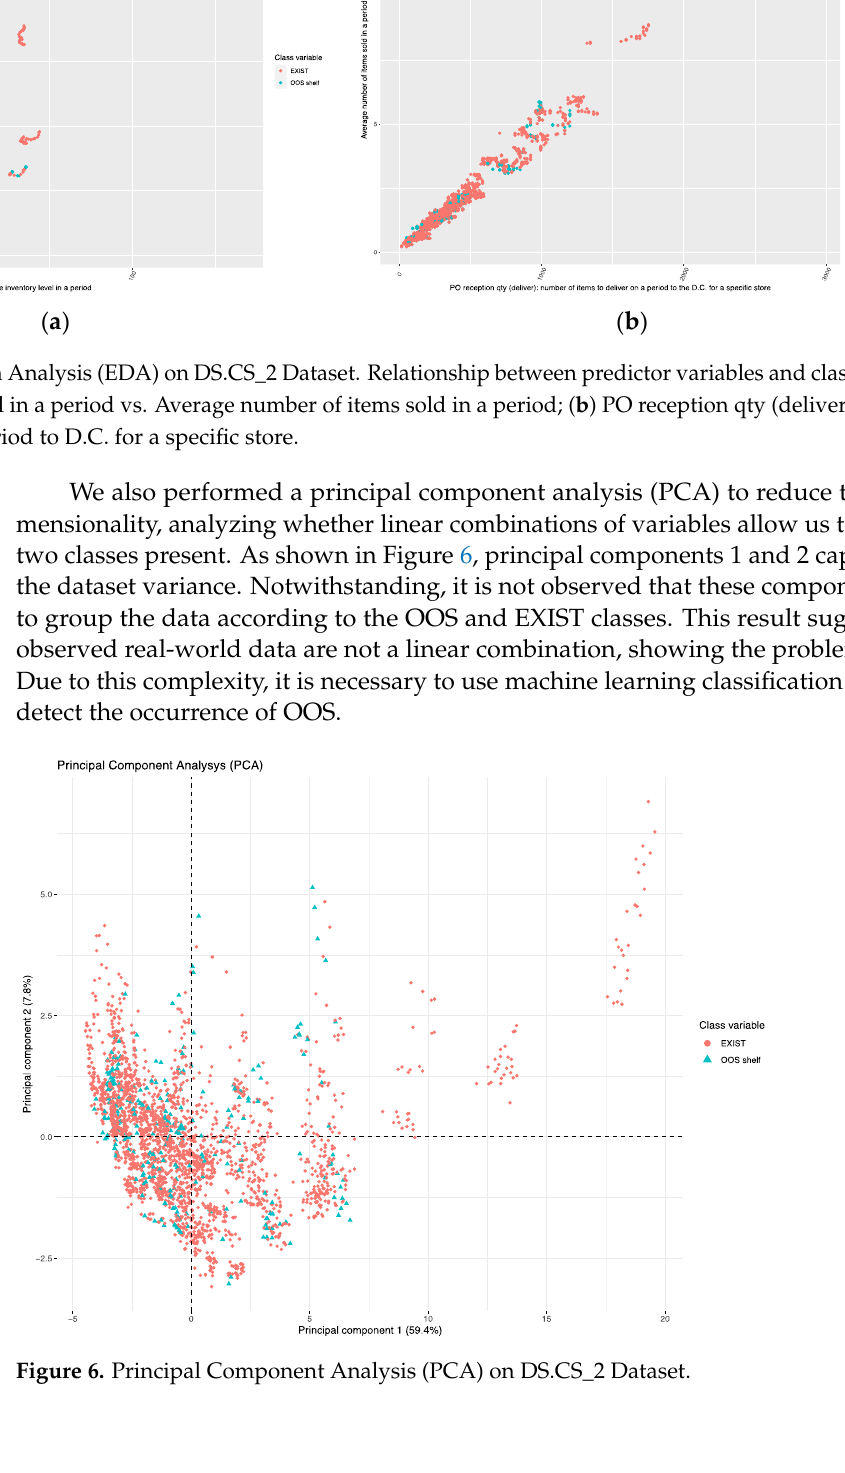
Figure 6. Principal Component Analysis (PCA) on DS.CS_2 Dataset.